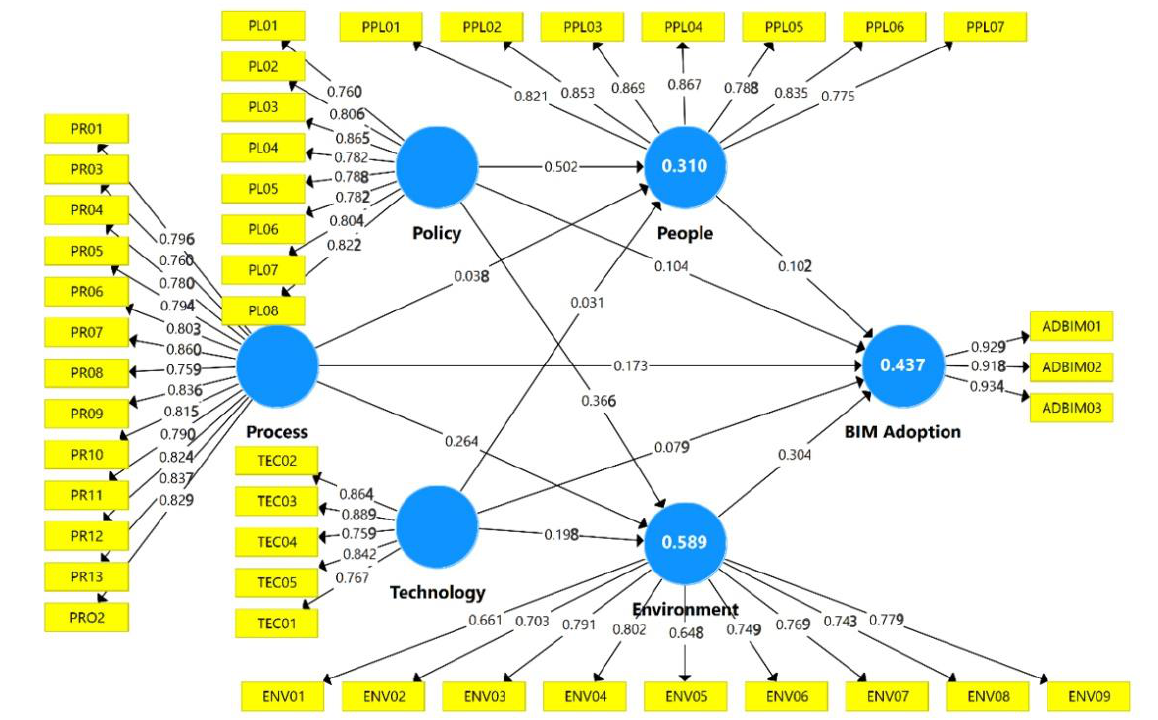
Figure 3. Factor loadings/outer loadings of each item calculated through the PLS algorithm.